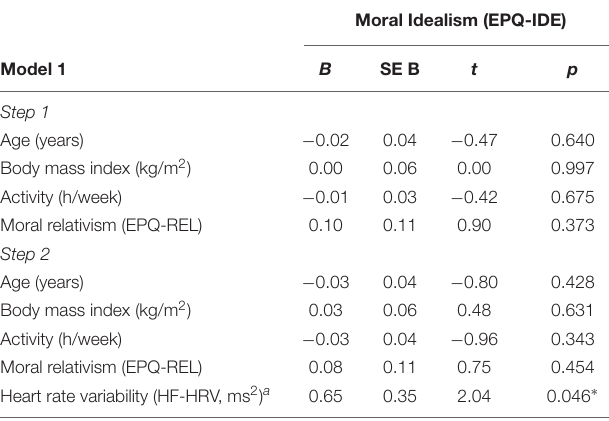
TABLE 3 | Association of moral idealism (EPQ-IDE) with heart rate variability (HF-HRV) under control of moral realism (EPQ-REL). Moral Idealism